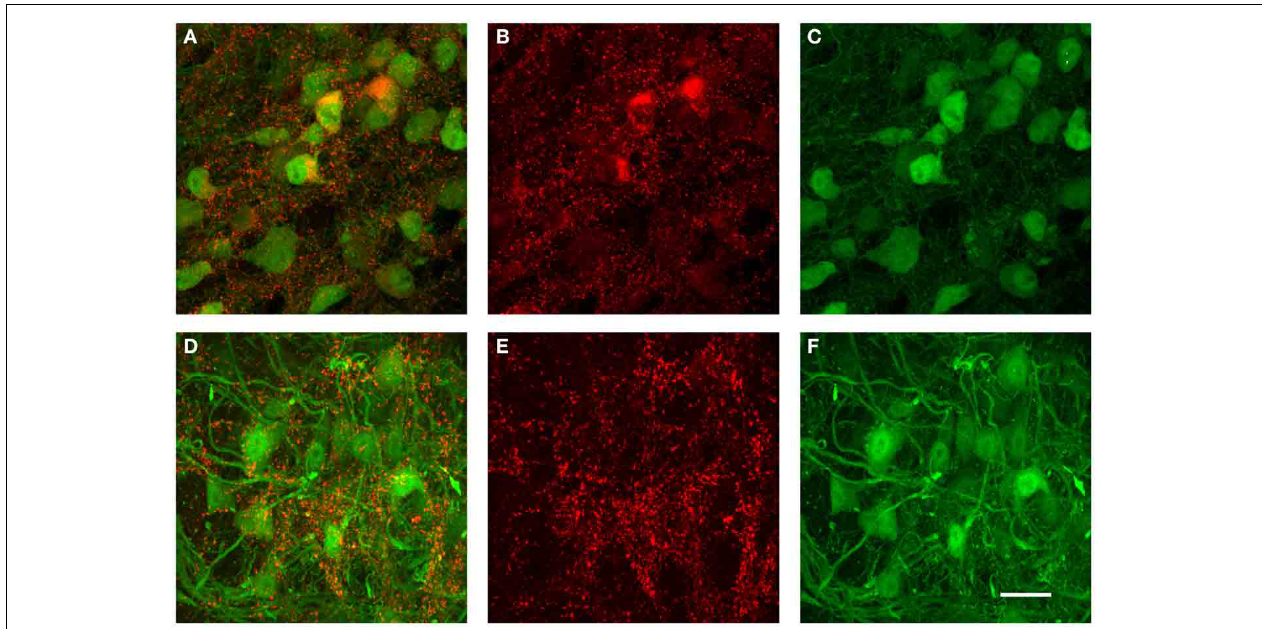
FIGURE 10 | Examples of immunohistochemical label against GAD67 in the VNTB of GlyT2-GFP mice. (A–C) show a representative anti-GAD67 labeling pattern in the VNTB of a p14 mouse, with (A) being the overlay of both channels, (B) the antibody labeling in red and (C) the GlyT2-GFP expression in green. Images shown in (D–F) show the same labeling in an